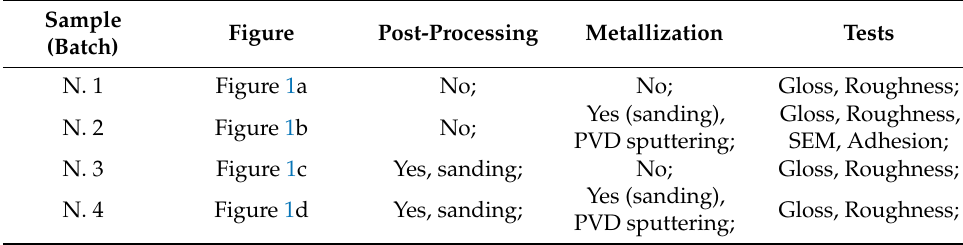
Table 2. Sample batches with the corresponding specifics (post-processing, metallization) and characterization